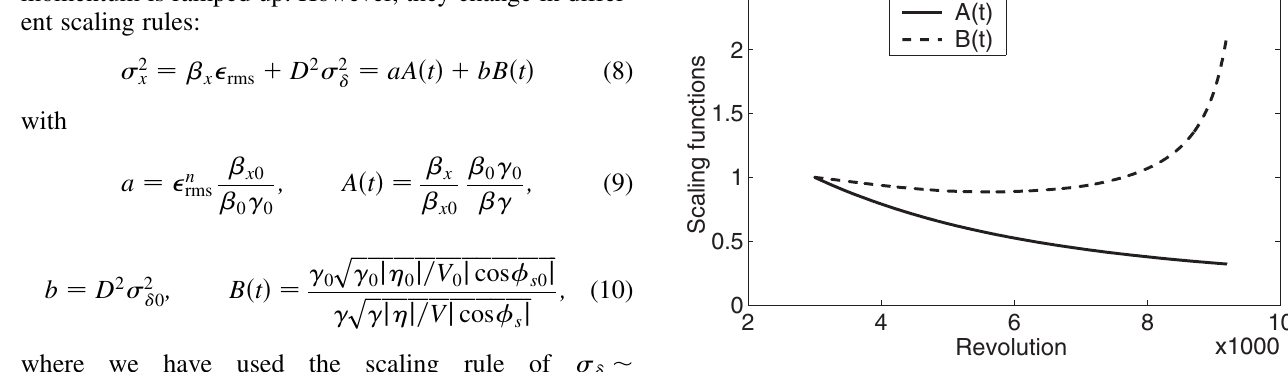
FIG. 16. Scaling function A (cid:3) t (cid:4) and B (cid:3) t (cid:4) , obtained with realistic booster lattice model and rf parameters.